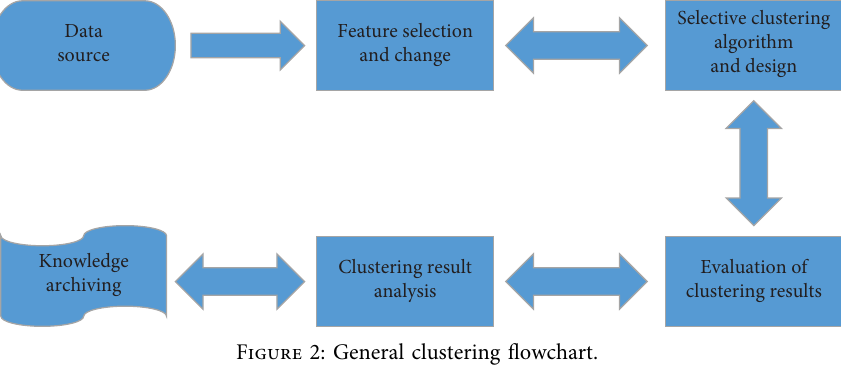
Figure 2: General clustering fowchart.